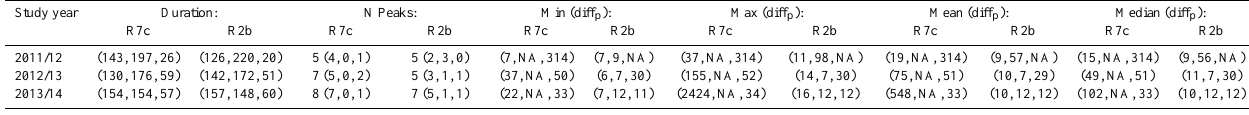
Table 5. Peaks observed at R2b and R7a during the 3 different study years. For each year and for both stations, the duration (days) of the snow-free, the snow cover, and the zero curtain period, the number of peaks per period (snow-free, snow cover, zero curtain; the number outside the brackets refers to the total number during this study year), and summary statistics of the strength of the peaks (diff p ) for the different periods are given. The first number in brackets refers to the snow-free, the second to the snow cover (excluding days with zero curtain), and the third to the zero curtain period. Both winter snow cover and the zero curtain period are derived from GST measurements next to the GPS station (Sect. 3.2).